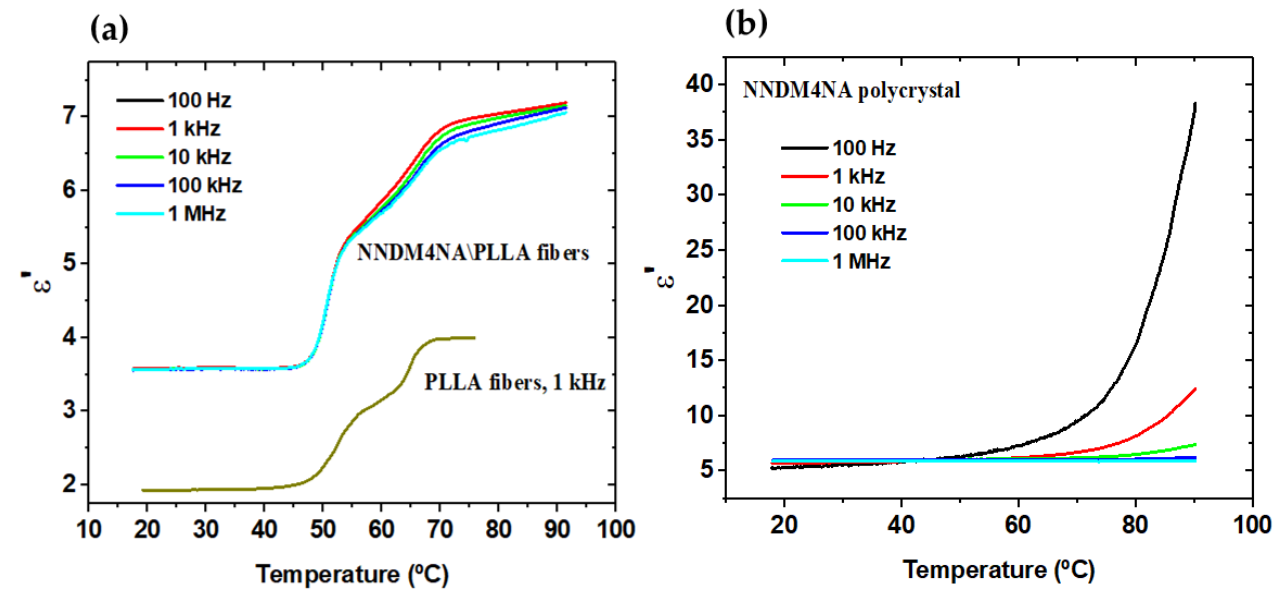
Figure 5. Temperature dependence of the dielectric constant (ε′) at different frequencies of ( a ) NNDM4NA@PLLA and the pure PLLA nanofiber array, ( b ) the polycrystalline pellet of